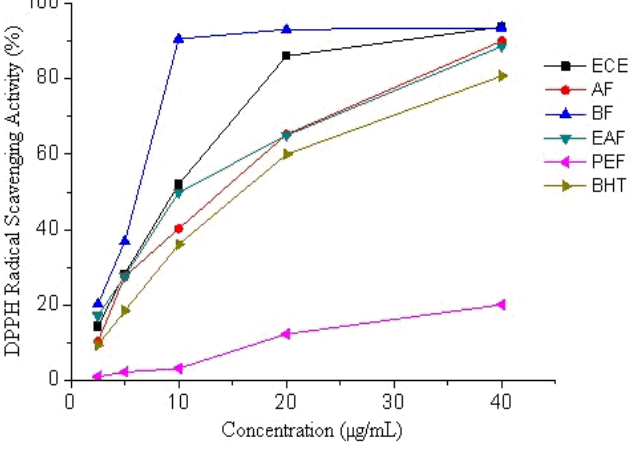
Figure 1. DPPH radical scavenging activity of ethanolic crude extract (ECE) and fractions of Receptaculum Nelumbinis (petroleum ether fraction (PEF), ethyl acetate fraction (EAF), n -butanol fraction (BF) and the aqueous fraction (AF)).